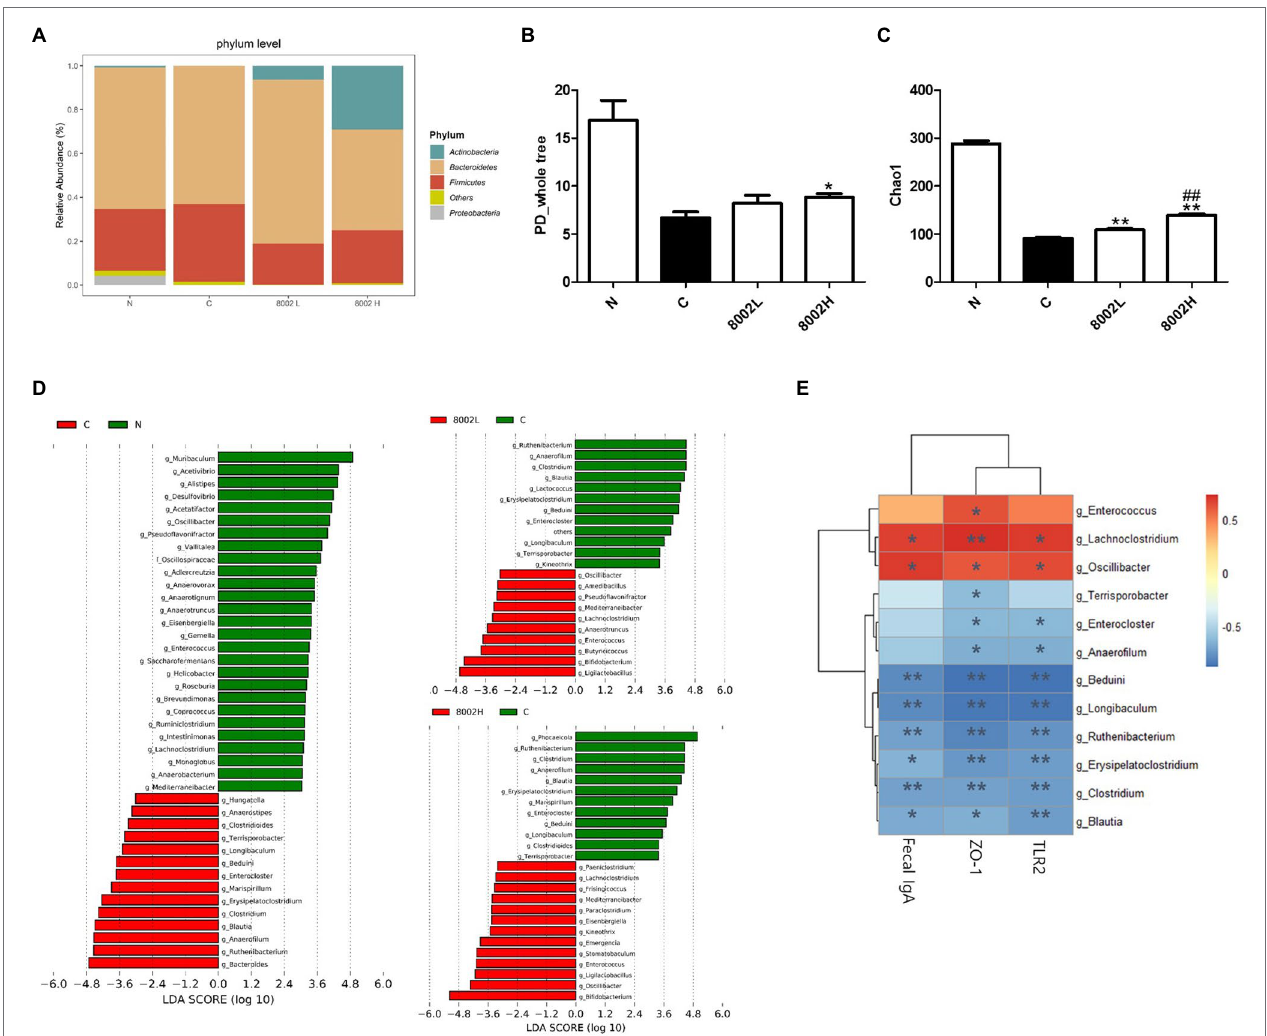
FIGURE 9 | Effect of HY8002 administration on the composition of bacterial taxa in mouse feces. (A) Relative abundance of phylum level in each treatment group. The α -diversity of each group: (B) PD_whole tree index and (C) Chao1 index. (D) Histogram of the linear discriminant analysis (LDA) scores for differentially abundant taxa following kanamycin treatment. (E) Correlation between bacterial genus-level taxa and measured intestinal integrity-related factors. Statistical analysis was conducted by the spearman correlation analysis. Data are represented as mean ± SEM. * p < 0.05 and ** p < 0.01. ## p < 0.01 compared with 8002L groups. N, normal group ( n = 4); C, kanamycin administration group ( n = 4); 8002L, kanamycin with 1.0 × 10 8 CFU/kg/day HY8002 administration group ( n = 4); 8002H, kanamycin